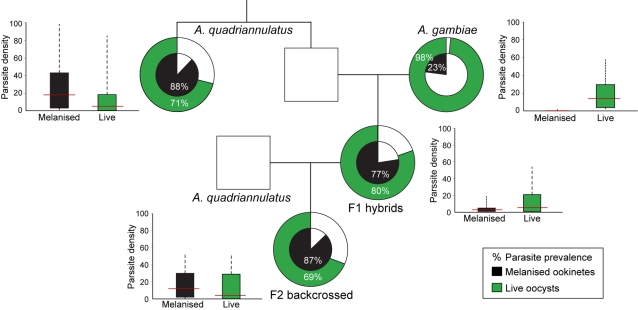

An. quadriannulatus refractoriness to Plasmodium is heritable and dominant.F1 hybrids were obtained by crossing male (square) An. quadriannulatus with female (circle) An. gambiae. F1 hybrid females were then backcrossed with An. quadriannulatus males to obtain F2 backcrossed mosquitoes. The prevalence of melanized parasites (inner pie, black) and live oocyst (outer pie, green) in the midguts of females from the parental An. quadriannulatus (n = 49) and An. gambiae (n = 53) populations, F1 (n = 66) and F2 (n = 86) are shown as concentric pie charts. Box plots depict the distribution of melanized ookinetes (black) and live oocysts (green) in each female mosquito group, with the respective median value shown in red. Two independent experiments were performed and the pooled data were analyzed using the Chi-square goodness-of-fit test for the prevalence and the Kruskal-Wallis non parametric ANOVA for the parasite densities. n refers to the number of mosquito midguts in the pooled data.